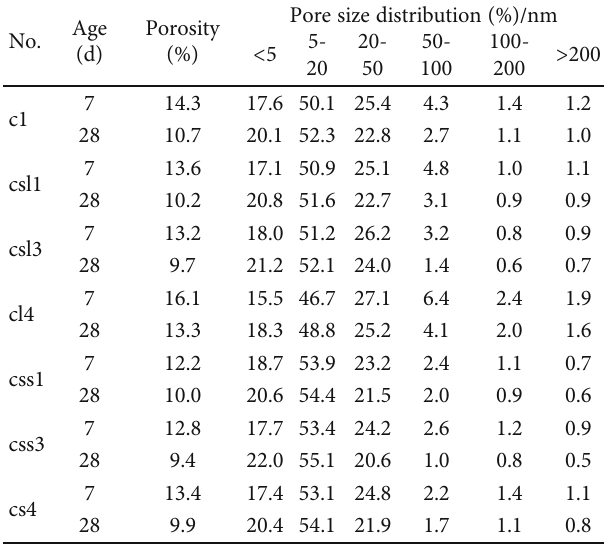
Table 4: Test results of pore structures of hardened